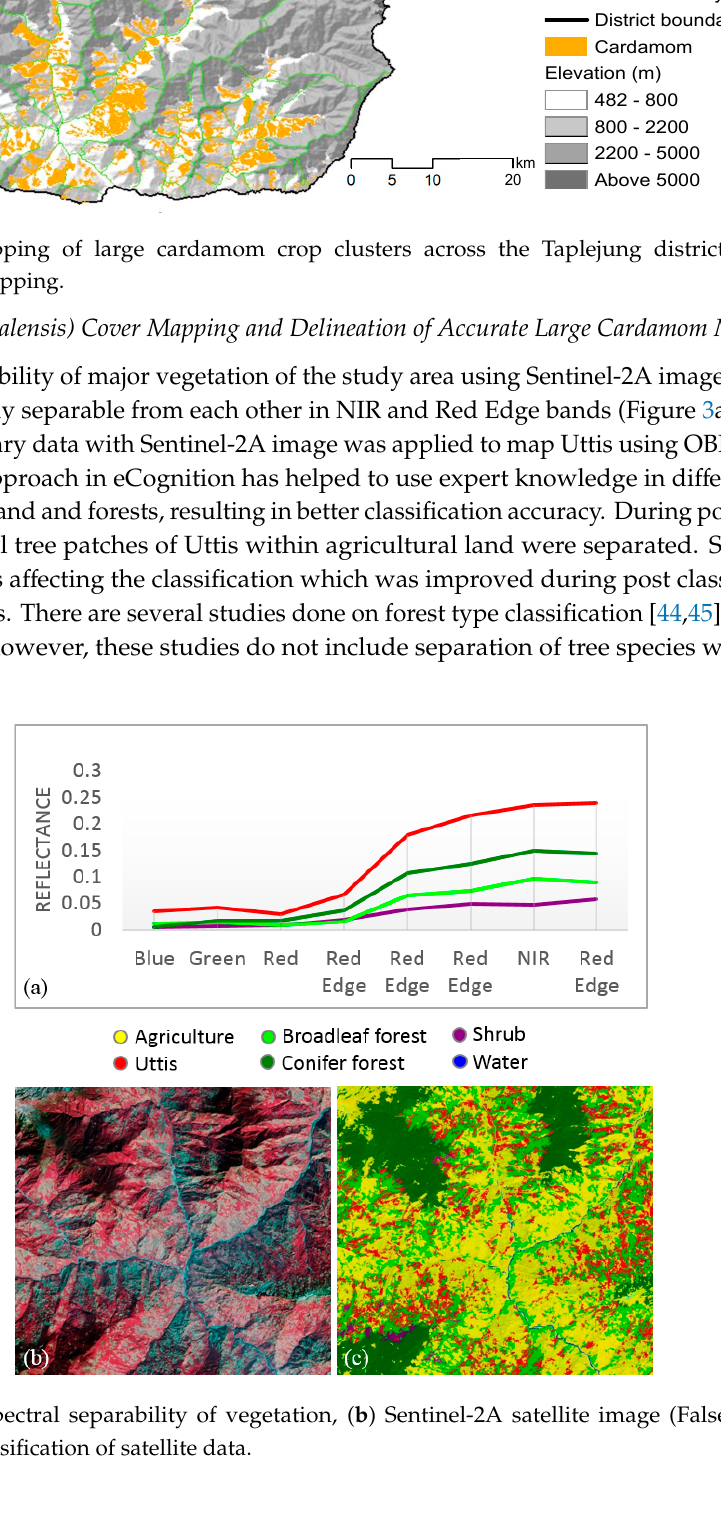
Figure 3. ( a ) Spectral separability of vegetation, ( b ) Sentinel-2A satellite image (False color), ( c ) object-based classification of satellite data.